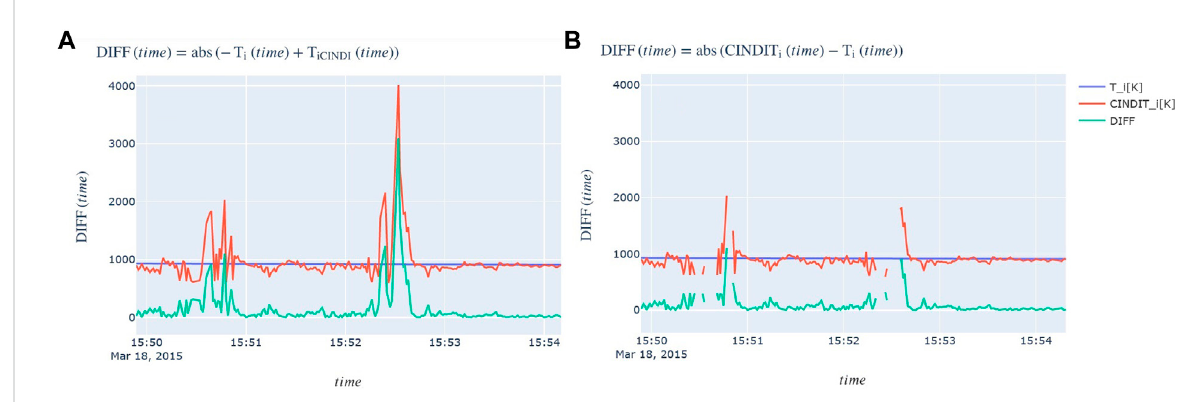
FIGURE 10 Comparisonofthemodel-datacomparisonwork fl owresultsusingonlyKamodo(left, (A) andpysat+Kamodo(right, (B) .Thedatashowninboth plots are approximately 4 min sections of the plots shown in Figure 7 and Figure 9 (less than 1/20 of an orbit). The axes in each plot are nearly identical, with the TIE-GCM dataset shown in blue (nearly horizontal lines near 1000 K), the CINDI dataset represented in orange, and the DIFF calculatedfunctioningreen.Thetimecadencesandvaluesineachplotareidentical,exceptforthedatagapsintherightplot.Thesegapsresult from the data cleaning routines developed for the CINDI data in pysat, and are automatically propagated to the DIFF function in the function composition performed using